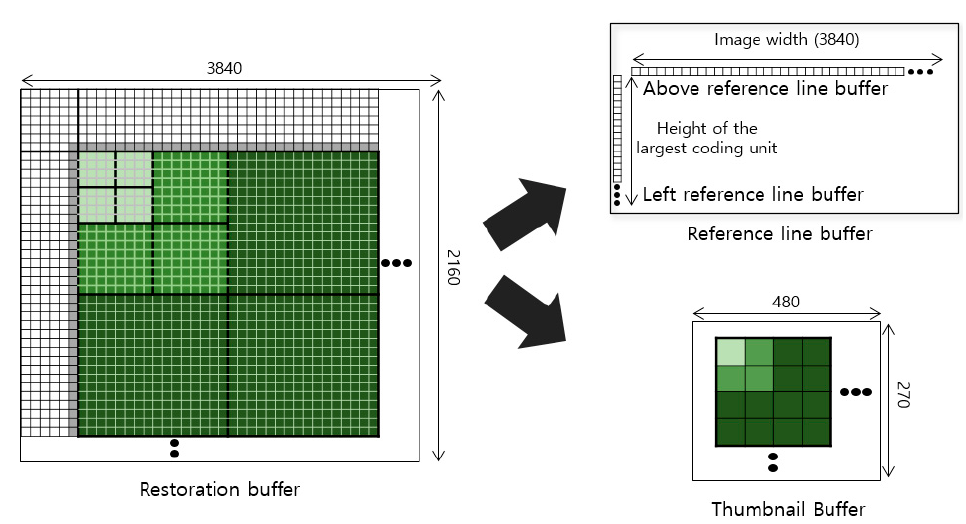
Figure 7. The proposed memory structure for a 3840 × 2160 input bitstream.